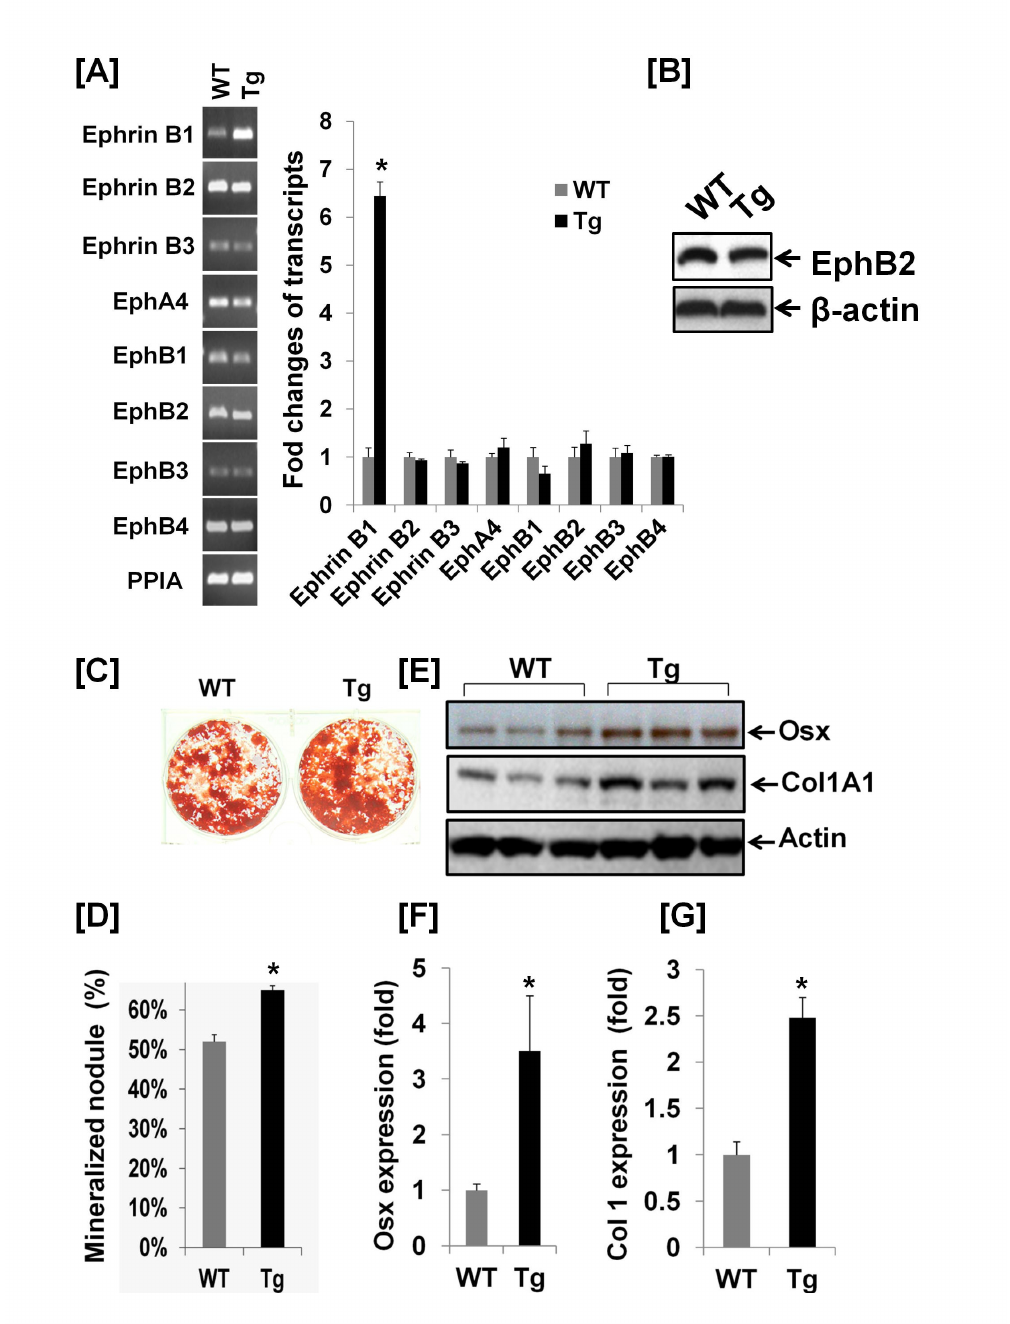
Figure 5. Overexpression of ephrin B1 increases osteoblast differentiation and osterix expression. [A] Multiple ephrin B ligands and ephrin receptors are expressed in bone marrow stromal (BMS) cells derived from WT and Tg mice, measured by real- time RT-PCR. [B] EphB2 expression in BMS cells, detected by Western blot analysis. [C] Images and quantitative data of mineralized nodules. [D] Quantitative data for mineralized nodule formation. BMS cells were differentiated for 24 days, followed by alizarin red staining and computerized quantification. Data are means ± SEM for N = 3 (3 mice/genotype). [E] Expression of osterix and collagen 1A1 (Col1) are increased in differentiated BMS cells, detected by Western blot analysis. BMS derived from WT and Tg mice were differentiated in the presence of ascorbic acid and beta-glycophosphate for 6 days prior to harvesting for Western blot analysis. [ F & G ] Quantitative data of osterix and col1 expression, measured by Western blot analysis. Data are means ± SEM for N = 4 (4 mice/genotype). A star represents statistical significance (P < 0.01) when compared to WT littermate controls. doi: 10.1371/journal.pone.0069051.g005 PLOS ONE |